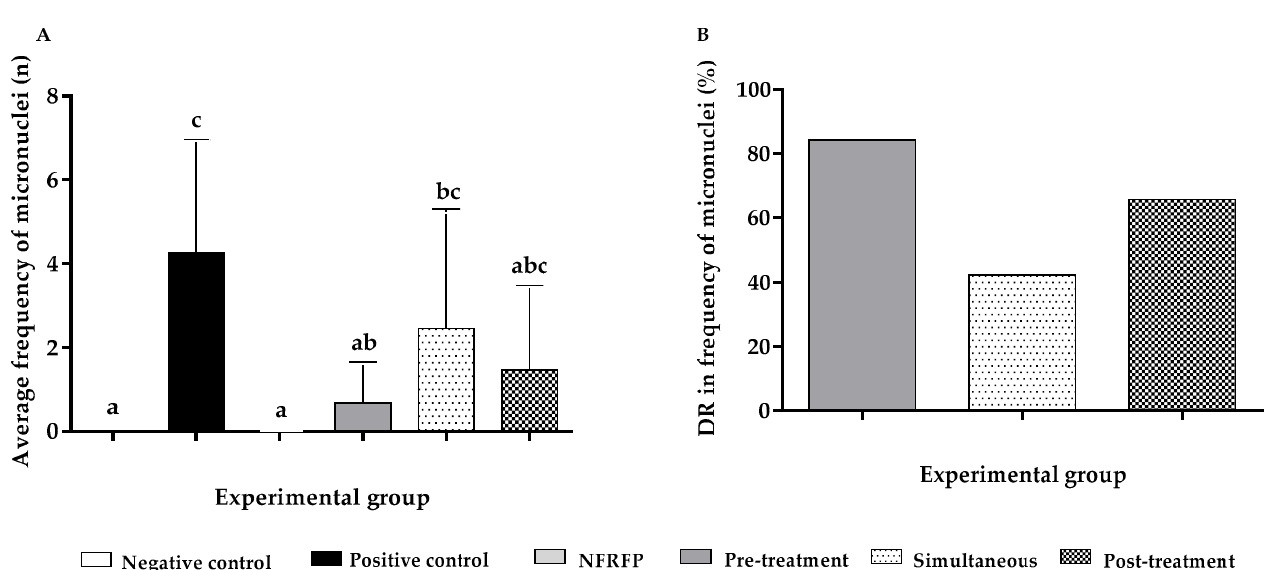
Figure 3. Chemopreventive action of the Natural Fiber-Rich Food Product (NFRFP), by the micronucleus assay, in different protocols for inducing DNA damage by 1,2-Dimethylhydrazine. ( A ) Average frequency of micronuclei; ( B ) DNA Damage Reduction Percentage. Different letters indicate statistically significant differences (Statistical Test: Kruskal-Wallis/Dunn; p < 0.05).